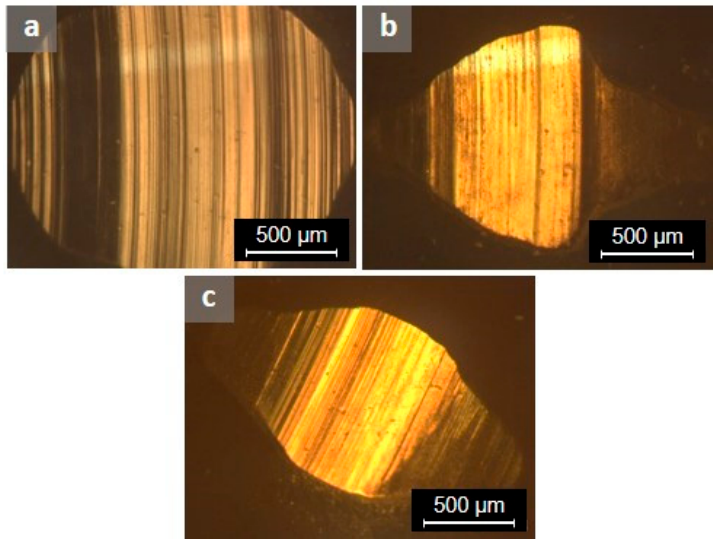
Figure 9. Wear tracks on balls after 20,000 laps, R10_N5 tests; ( a ) baseline type, ( b ) Hex_50 type, ( c ) Hex-D_50 type.